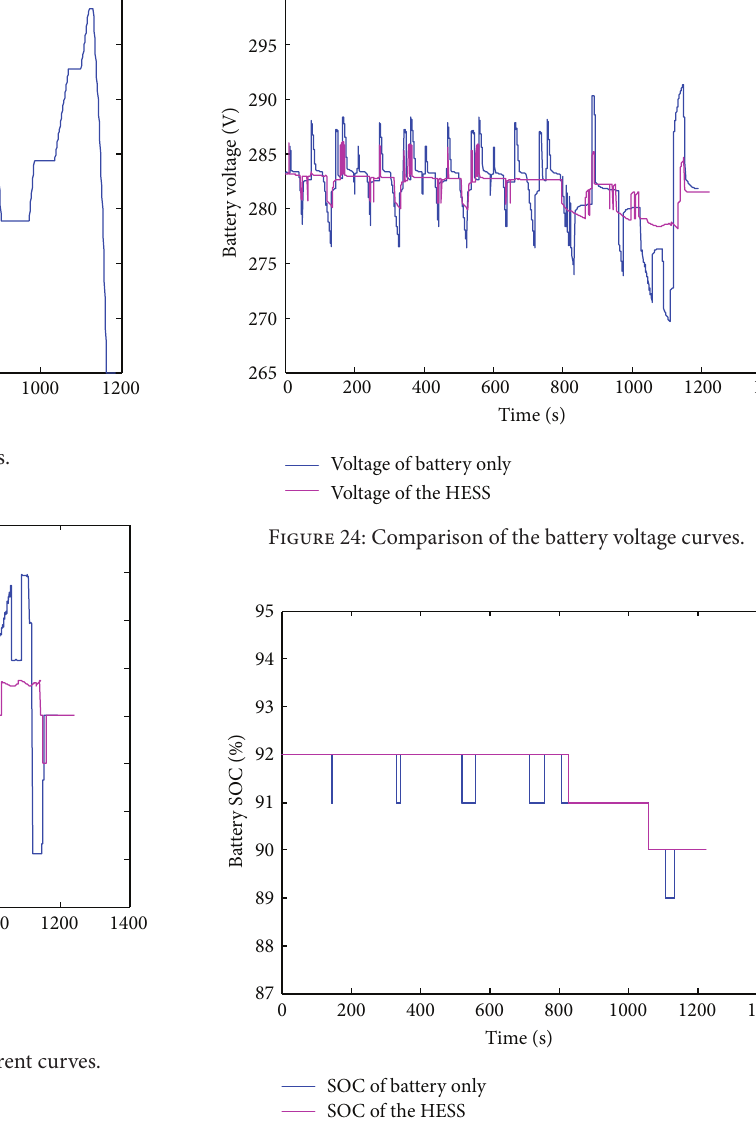
Figure 25: Comparison of the battery SOC